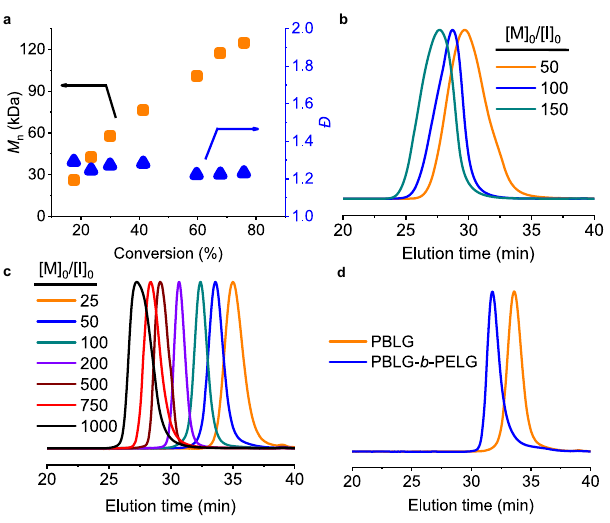
Fig. 3 MW control for CE-catalyzed polymerization of NCA. a The obtained MW and dispersity at various conversions during CE-catalyzed polymerization of BLG-NCA initiated by Hex-NH 2 in DCM. [M] 0 /[I] 0 =